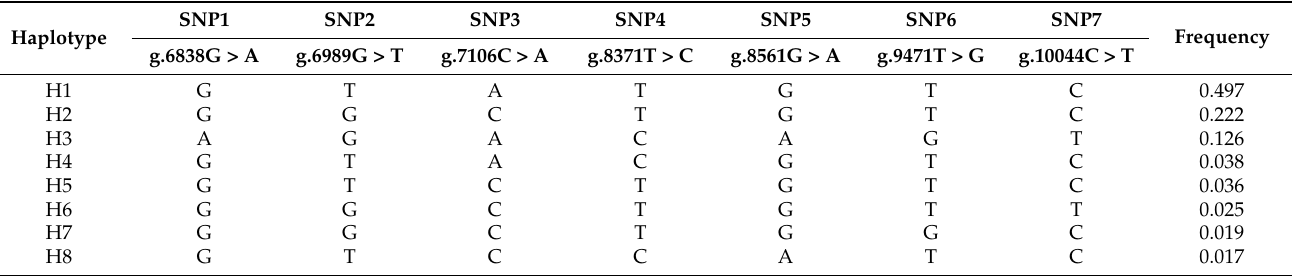
Table 2. Haplotypes of MYF5 gene and the frequencies in GSTS flock.